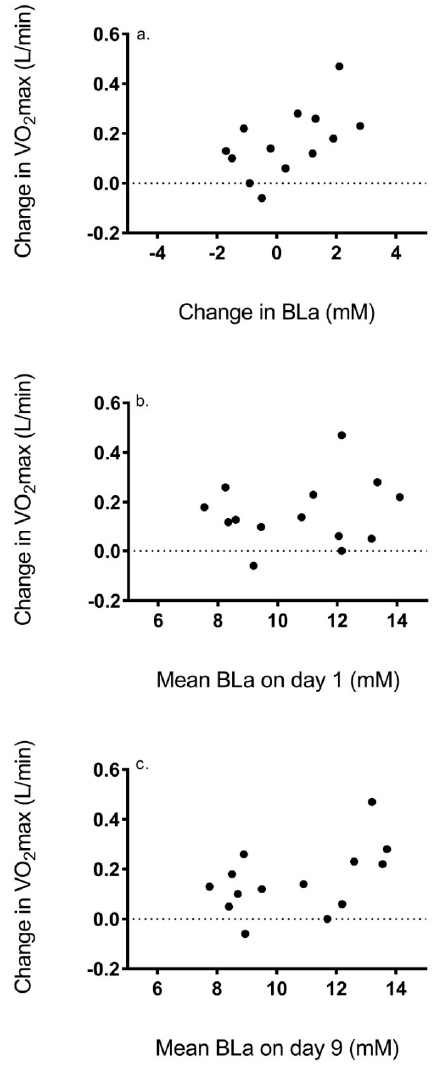
Figure 1. Association between change in VO 2 max and ( a ) change in blood lactate concentration, ( b ) blood lactate concentration on day 1 of training, and ( c ) blood lactate concentration on day 9 of training .